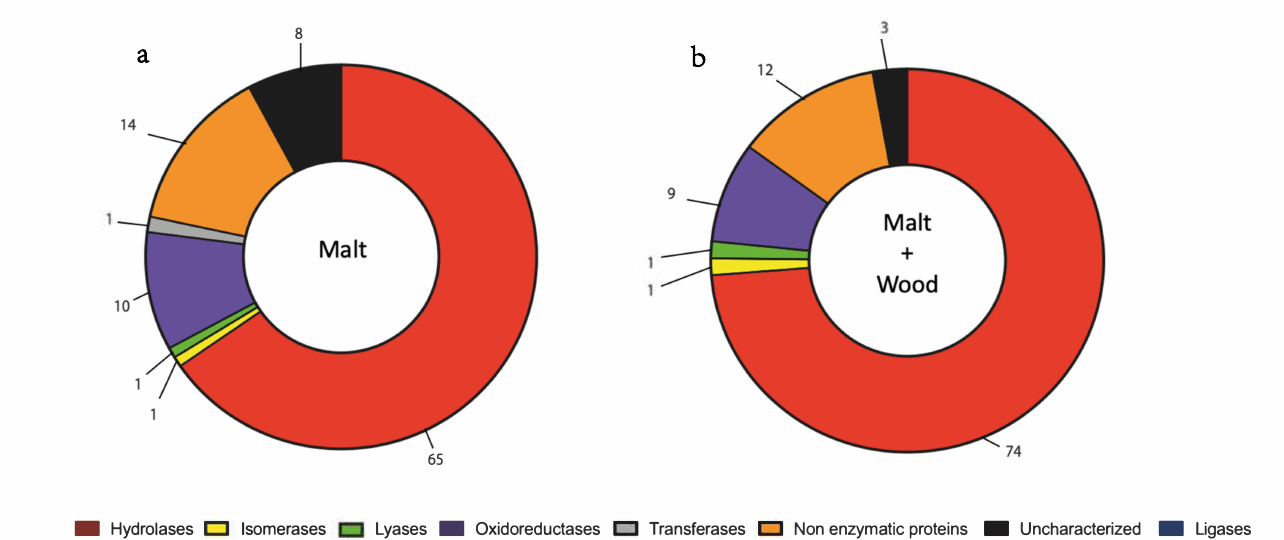
Figure 2. Classification of secreted protein based on molecular functions of N. parvum cultivated without ( a ) or with grapevine sawdust ( b ). The numbers are expressed in percentage of total proteins in each